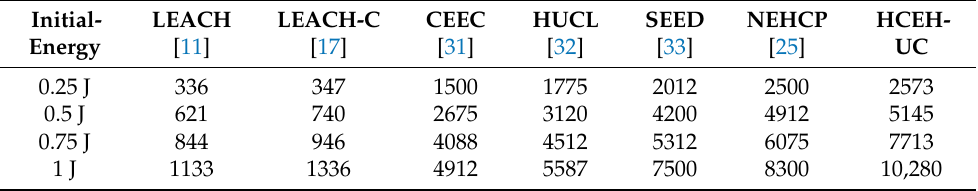
Table 5. MLC under a different initial energy.